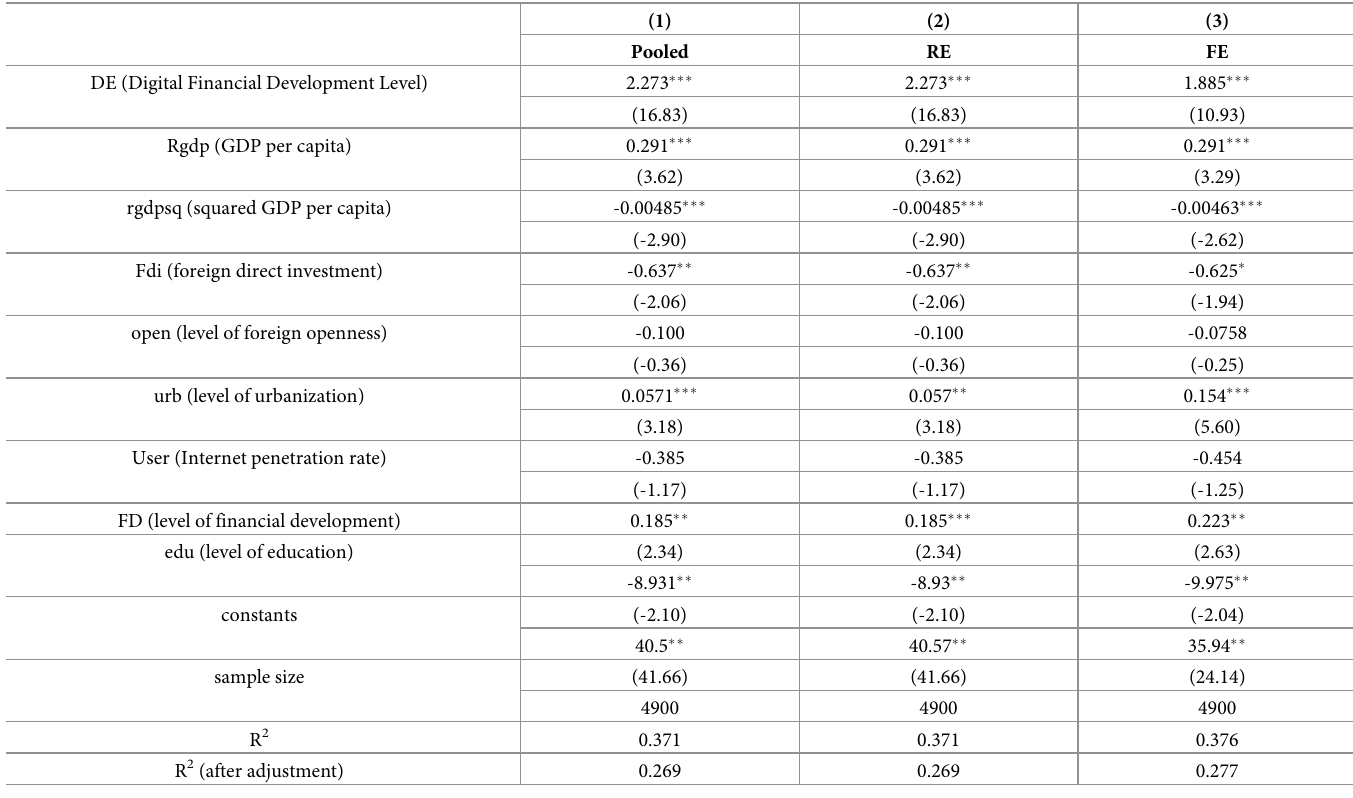
Table 2. Estimation results of the baseline